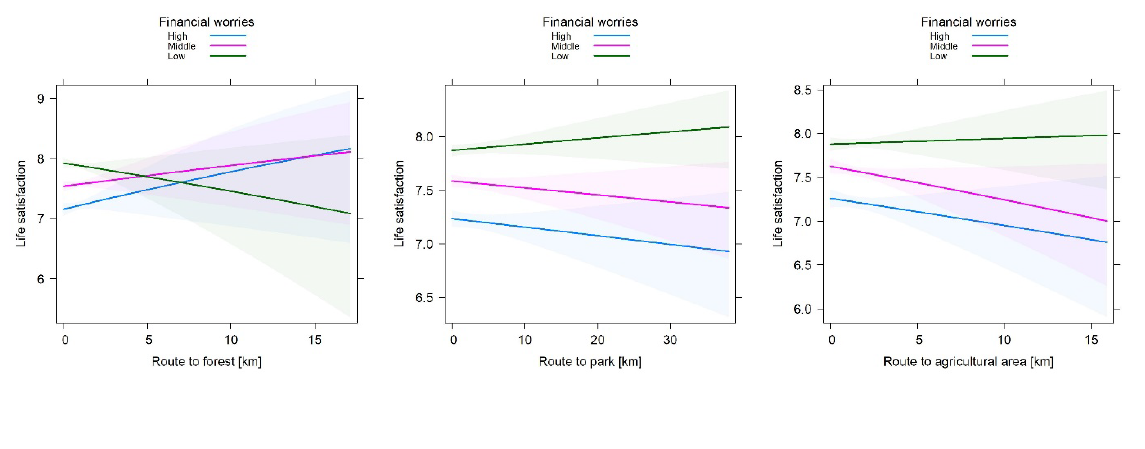
Figure S8 . Mutually adjusted associations of proximity to greenspace with life satisfaction by financial worries, adjusted for life satisfaction in the past, age categories, sex, household income, canton, degree of urbanisation, month of entry, and